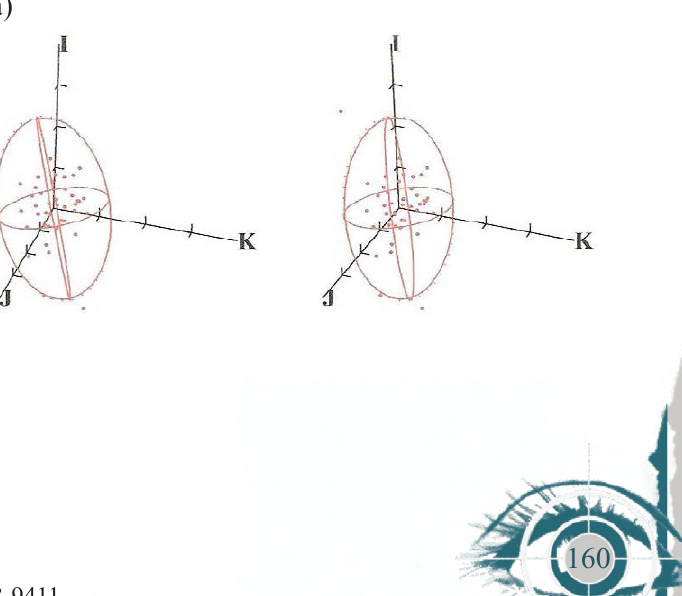
Figure 4: Stereo-pair scatter plots in symmetric dioptric power space for the anterior ( a ) and posterior ( b ) corneal keratometry for Subject